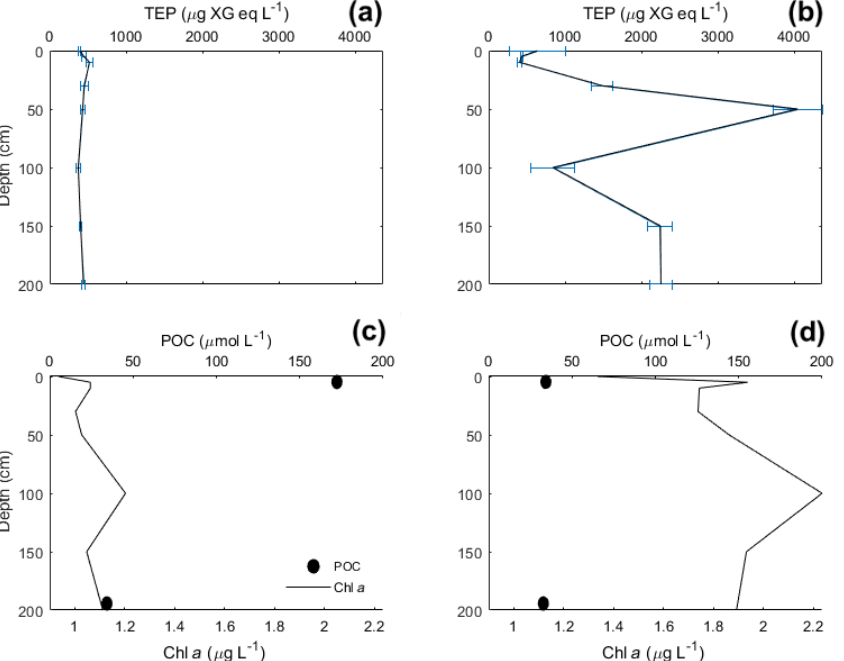
Figure 4. Vertical profiles from stations 5 and 9 during the Baltic cruise, showing the vertical distribution of TEPs (a, b) and Chl a /POC (c, d) . Stations were chosen to represent the general vertical TEP trends seen in the first and second halves of the cruise.